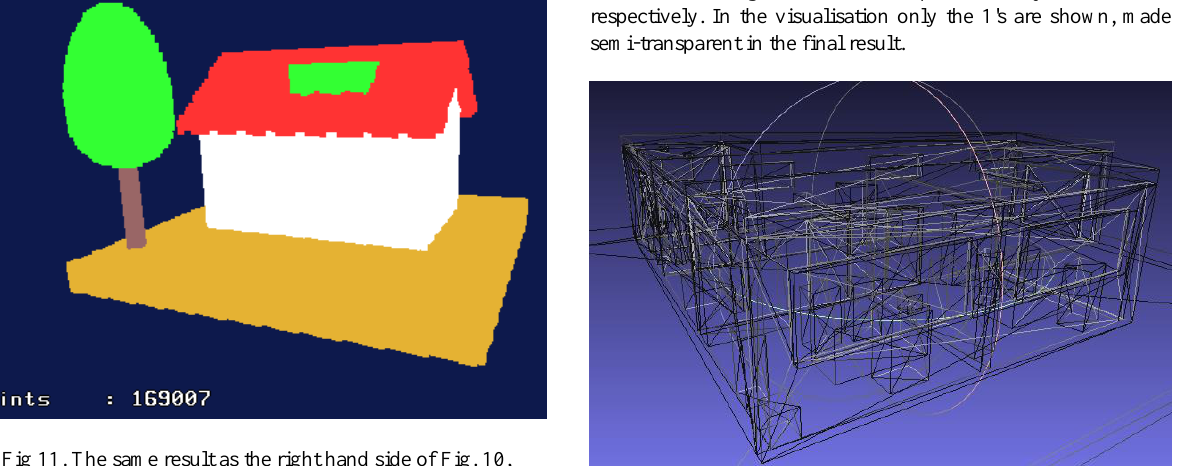
Fig 11. The same result as the right hand side of Fig. 10, shown with a larger voxel point size.